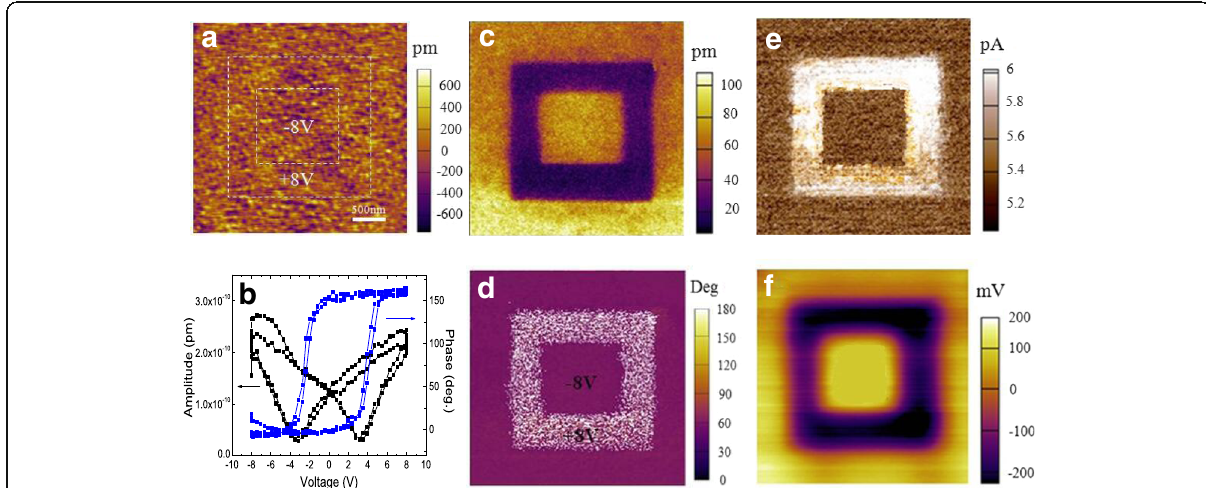
Fig. 2 a Surface morphology of the BTO films on NSTO substrates. b Local PFM out-of-plane hysteresis loops: blue, phase signal; black, amplitude signal. c PFM out-of-plane phase, d PFM out-of-plane amplitude, e current, and f SKPM images recorded over the same area ( a ) after writing an area of 2 × 2 μ m 2 with − 8 V and then the central 1.25 × 1.25 μ m 2 square with + 8 V using a biased conductive tip. The scale bar is 500 nm for the images of a and c – f . The labels in c – e are corresponding to the value of out-of-plane current, PFM phase, and PFM amplitude, respectively